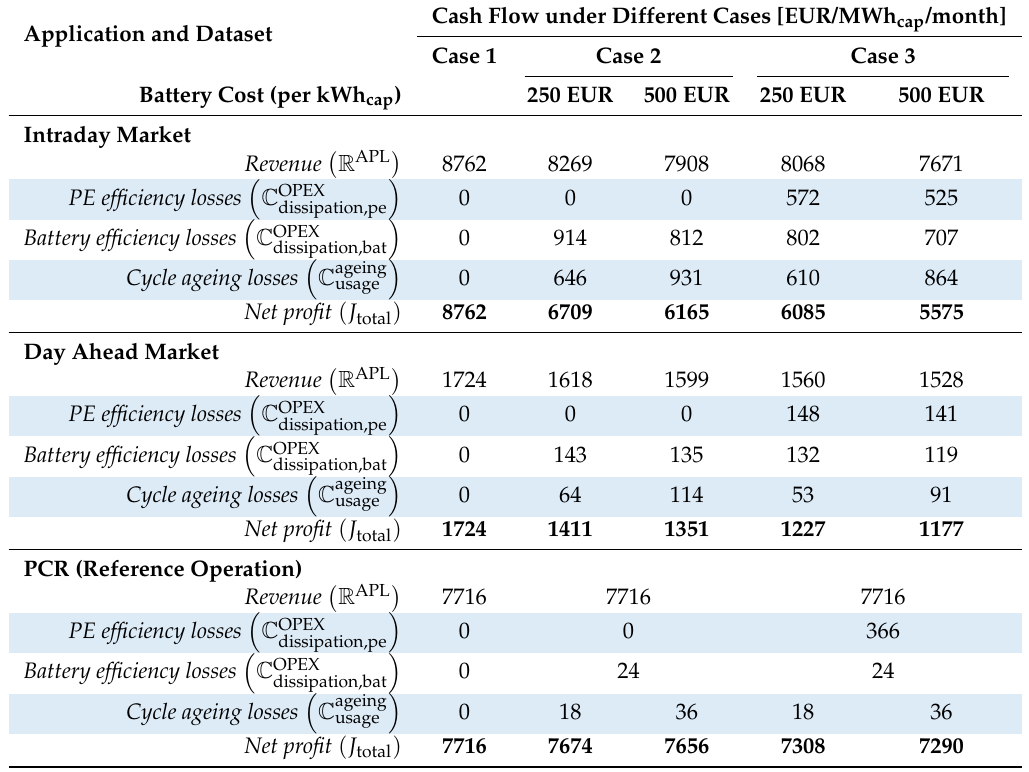
Table 2. Cash flow for storage operation in three use cases based on real-world data (2017). Application and